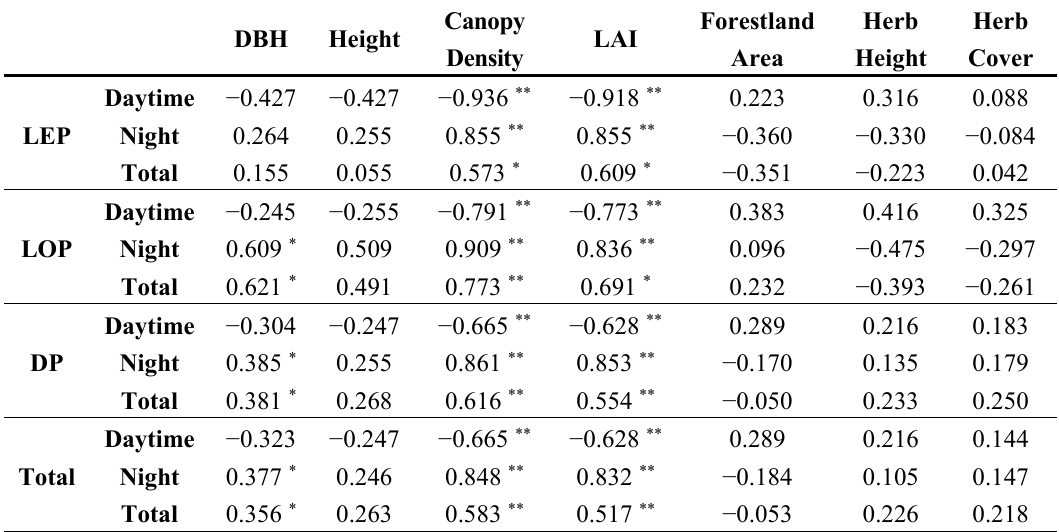
Table 3. Spearman Rank Correlation Coefficients between the PM 2.5 concentration index and forest structures.